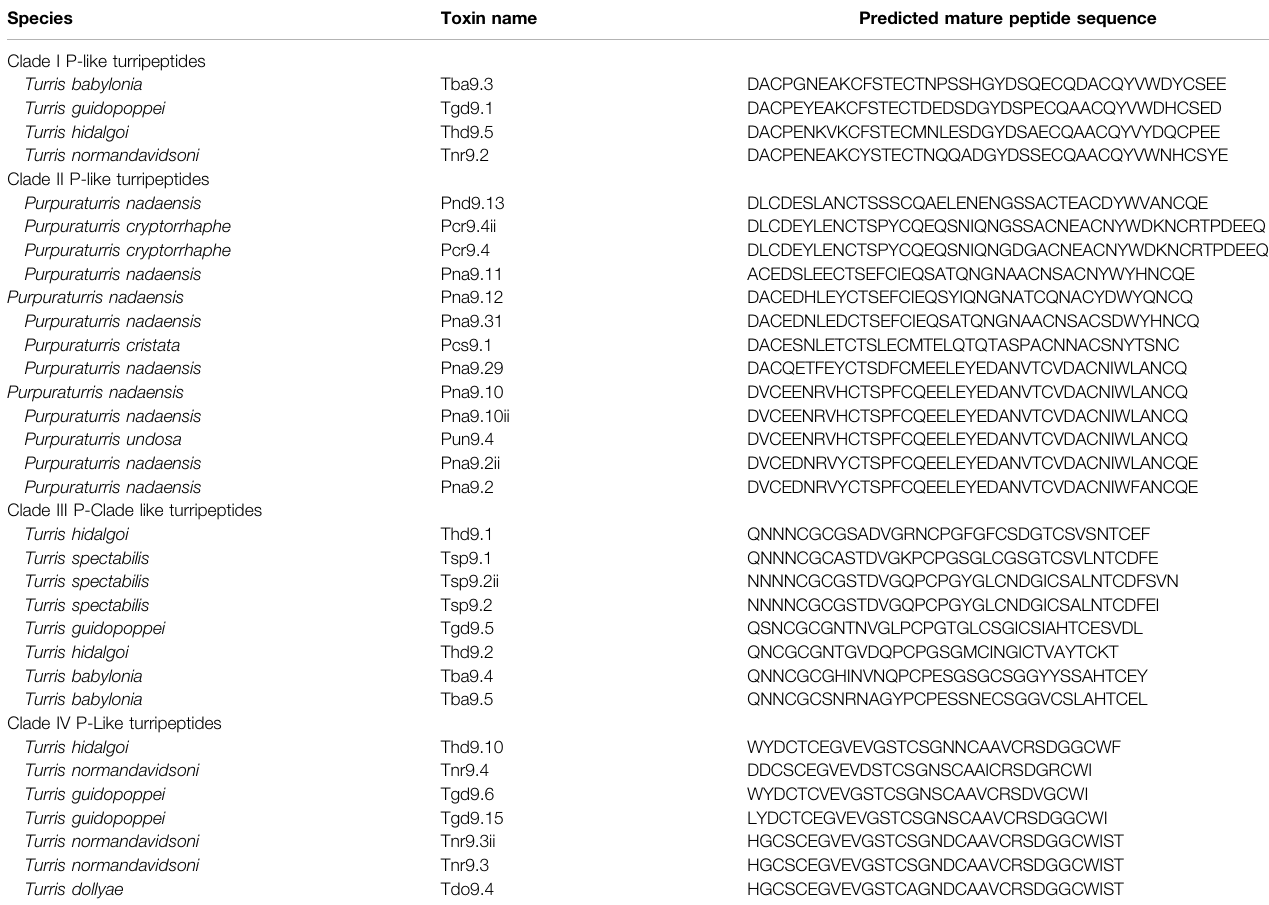
TABLE 1 | Predicted mature P-like turripeptide